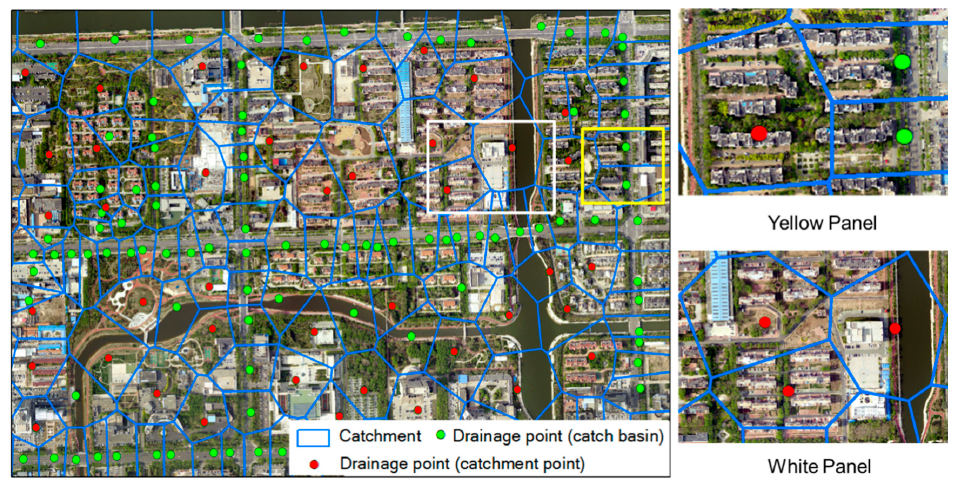
Figure 15. Land types with different flow directions partitioned as different catchment areas.